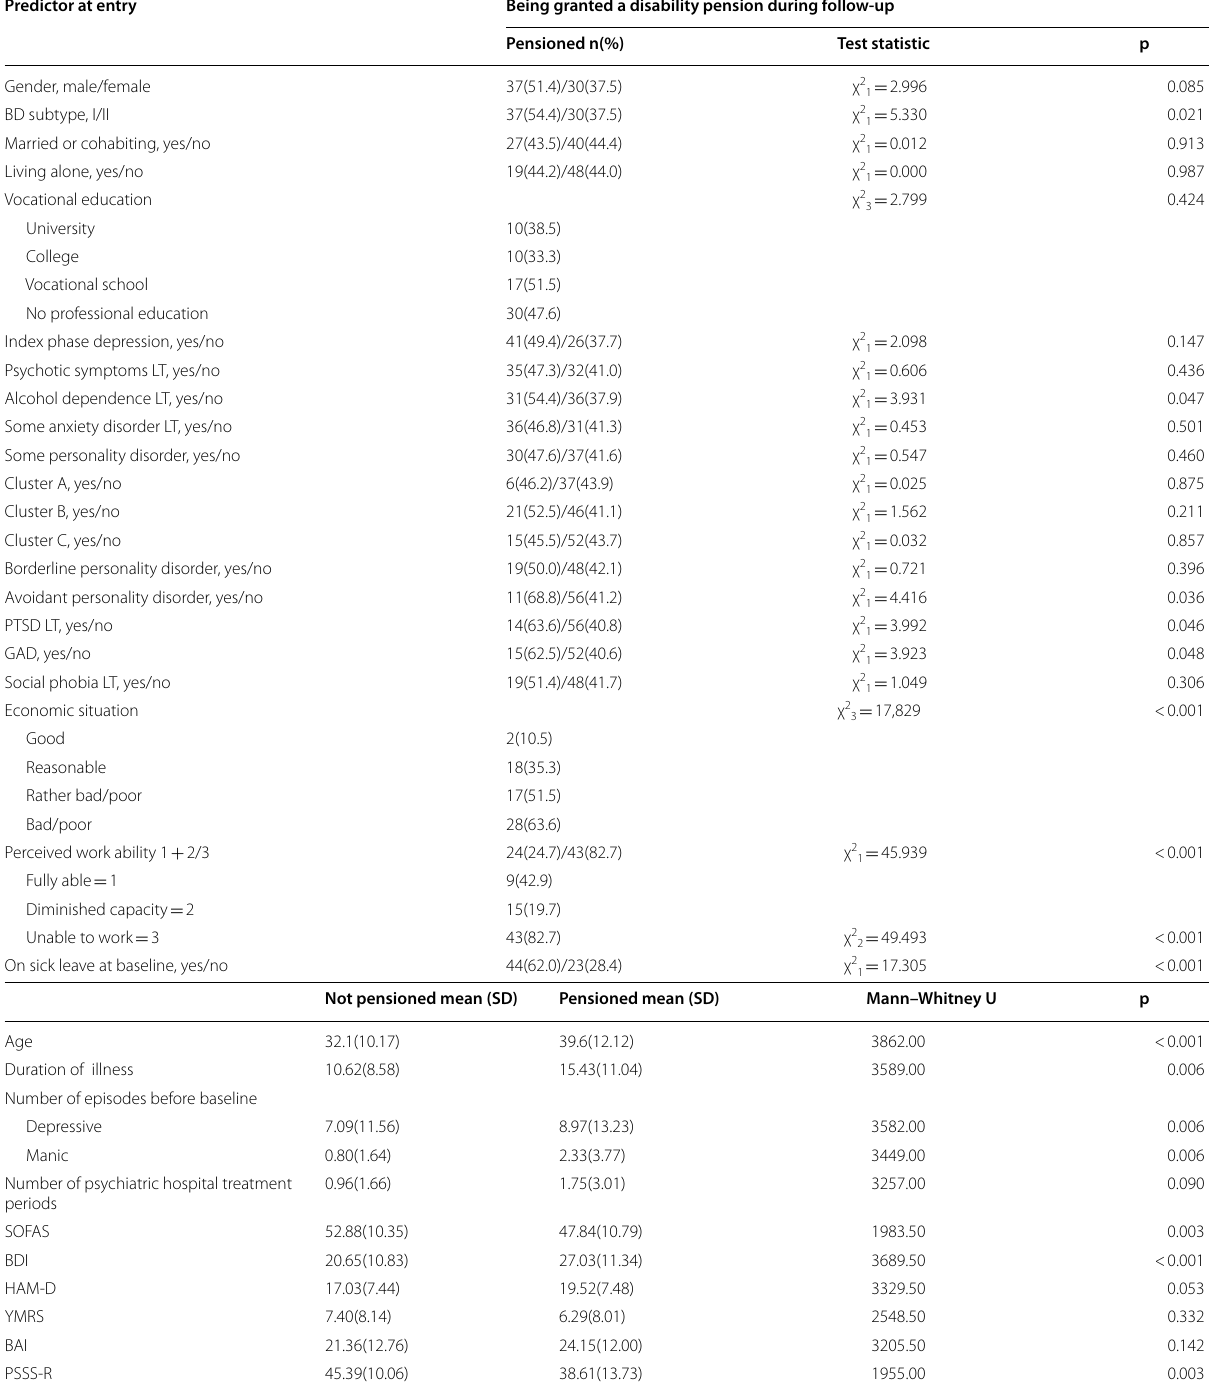
Table 1 Univariate analyses of predictors of work disability pension among employed patients with bipolar disorder in Jorvi Bipolar Study during 6-year